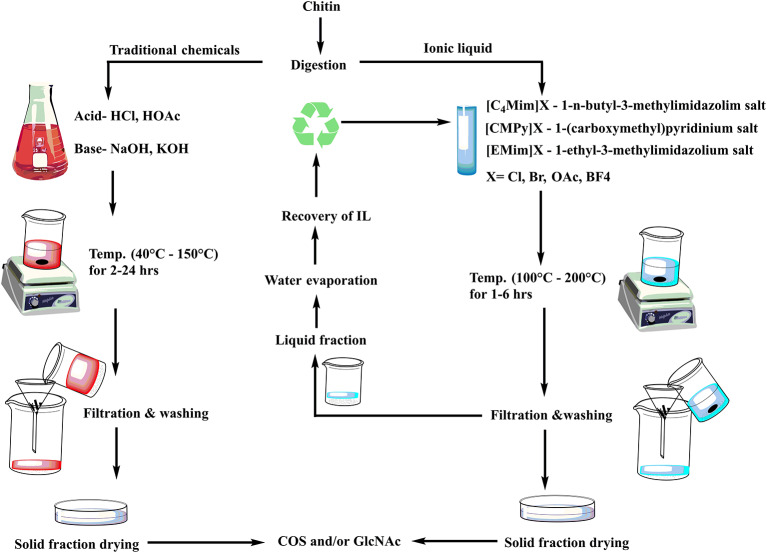
Different approaches for COS and GlcNAc production.